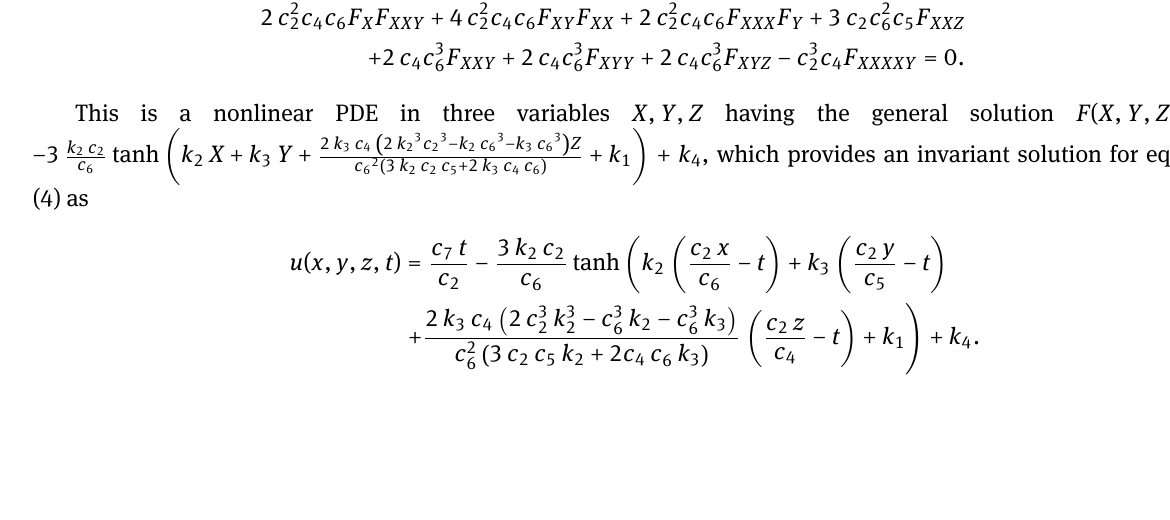
variables and F as a new dependent variable. Thus, equation (4) gets transformed